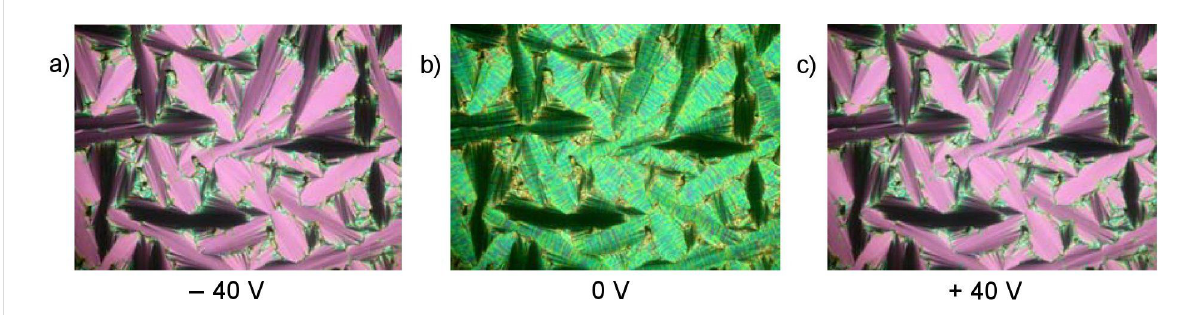
Figure 12: Compound OH 3b : Texture of the SmCP A phase in dependence on the polarity of the applied D.C. field.